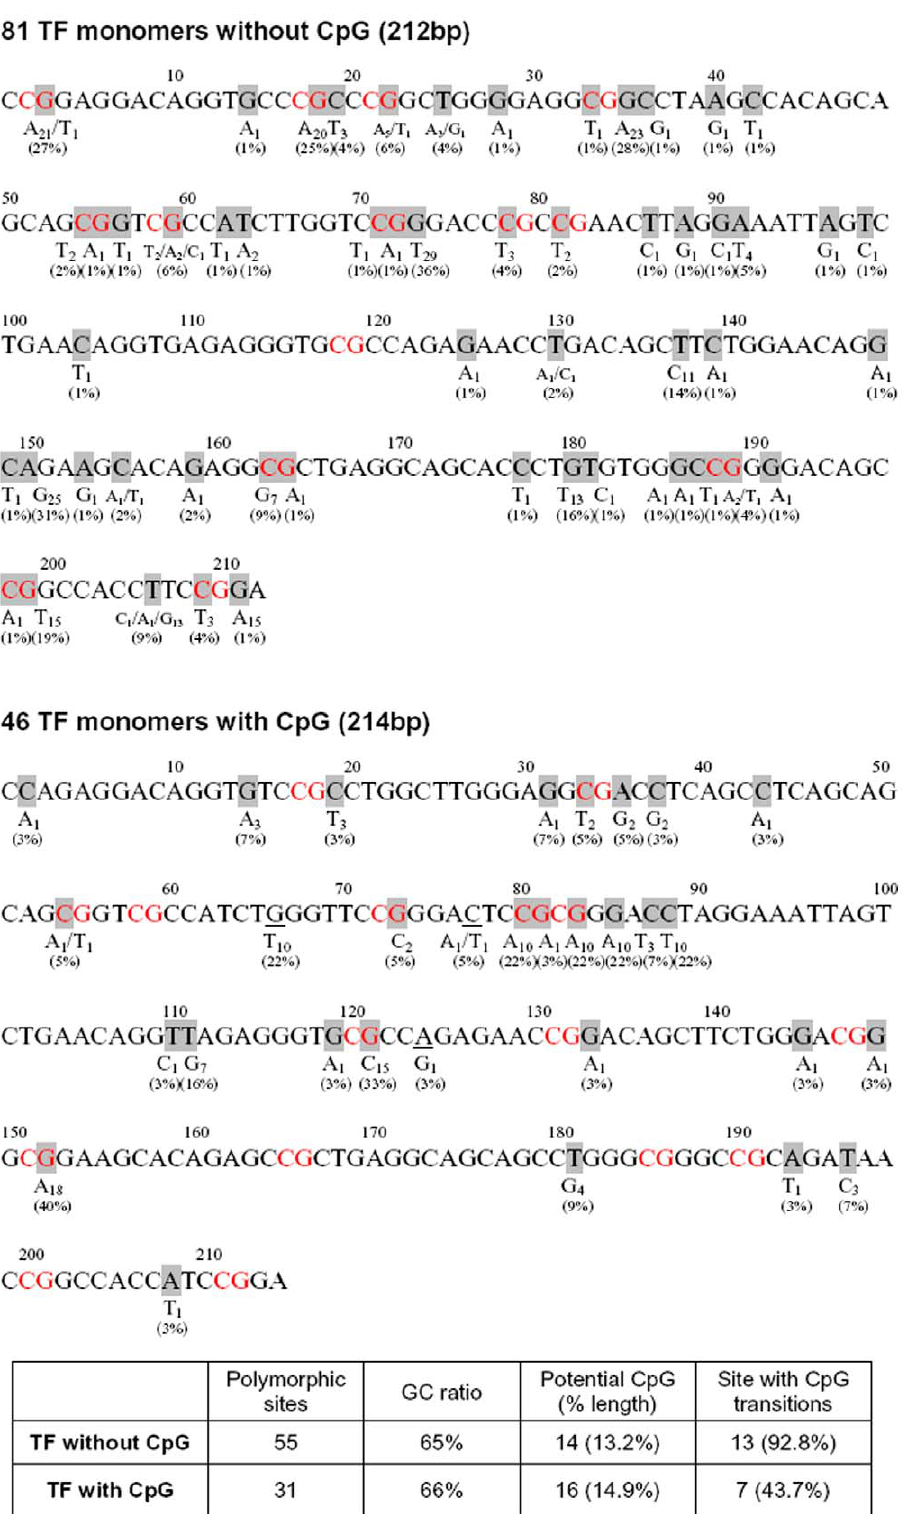
Figure 9. Analysis of polymorphism and CpG transitions of T F monomers. The number and percentage of mismatches, CpG island length, and CpG transition sites were analyzed in T F monomers containing or lacking a CpG island.